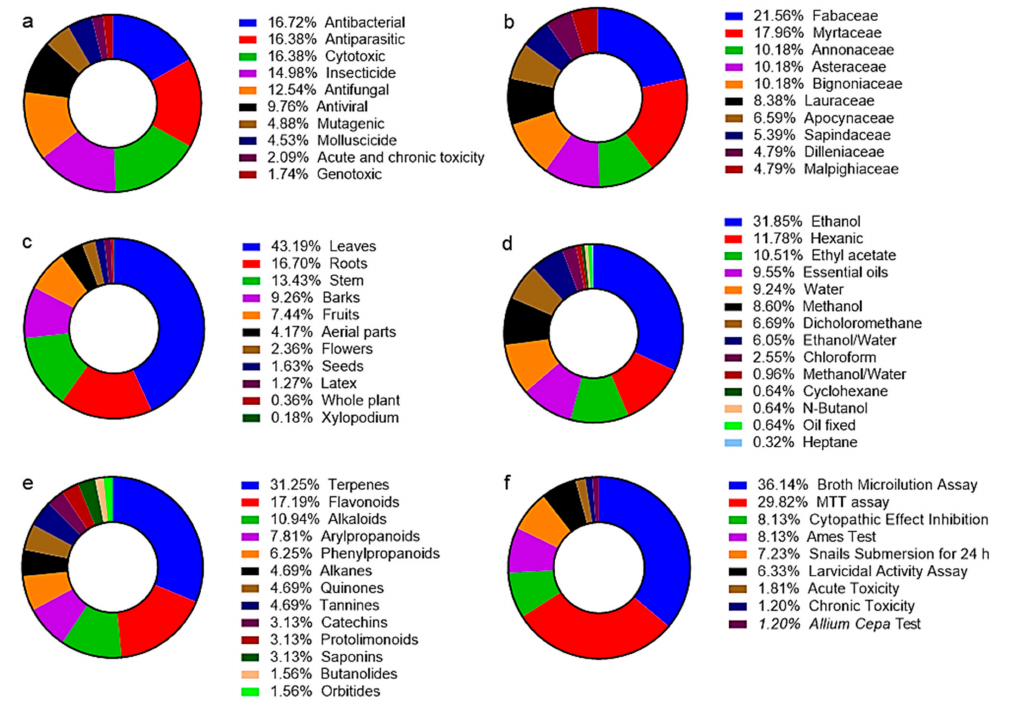
Figure 1. Summary of studies on the toxic activities of Cerrado plants included in the present review. The included manuscripts were screened to generate donut charts to visualize the proportions of ( a ) toxic activities studied, ( b ) plant families studied, ( c ) part of the plant studied, ( d ) type of extract or fraction studied, ( e ) classes of secondary metabolites studied, and ( f ) main techniques used to assess the toxicity of medicinal plants.